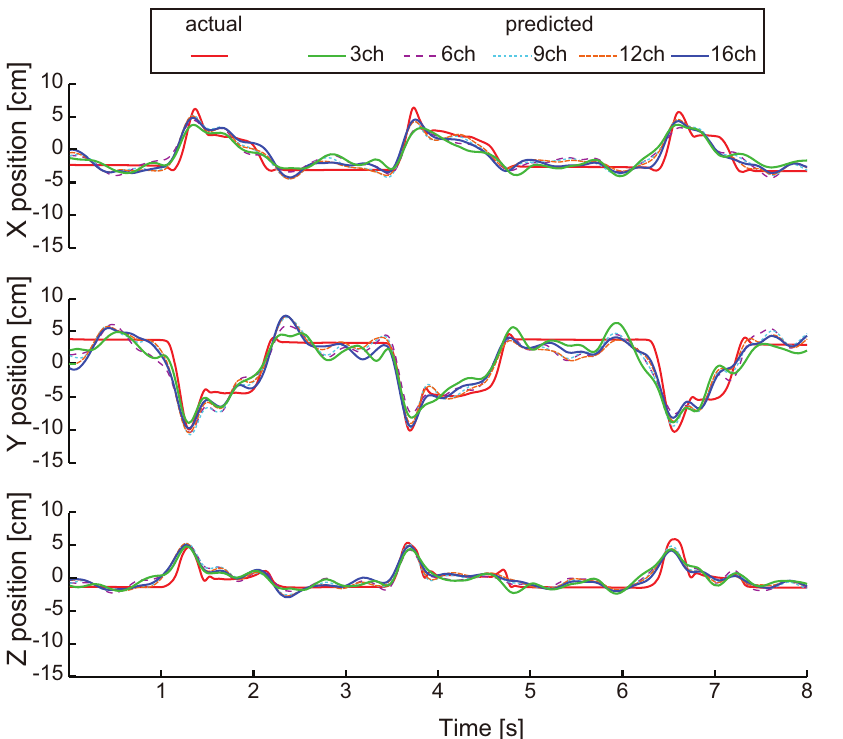
Figure 6. Decoding results for monkey B with different electrode numbers selected using the location-based method. Example prediction of 3D hand positioning over 8 s of test data using 3, 6, 9, 12, and 16 electrodes. The red solid line depicts actual trajectories. The green solid line, purple dotted line, light blue dotted line, brown dotted line, and blue solid line represent predicted trajectories using 3, 6, 9, 12, and 16 electrodes,